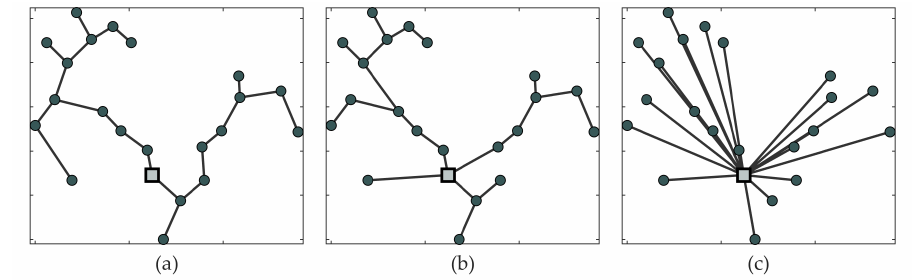
Figure 2. Topology types ( a ) MST, ( b ) Slime Mold solution, and ( c ) Star topology.